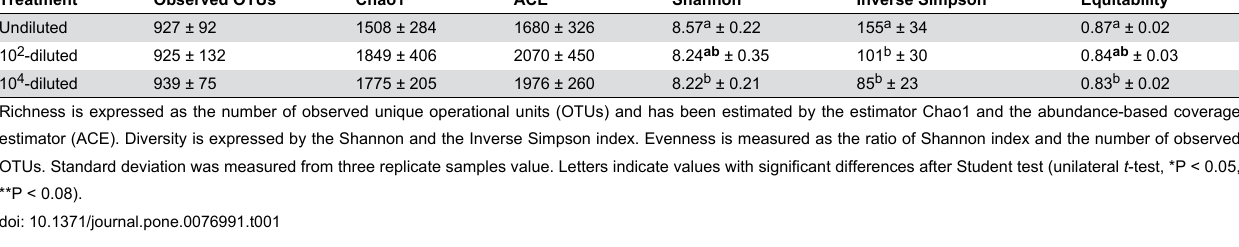
Table 1. Bacterial richness, diversity and evenness at a genetic distance of 5%.